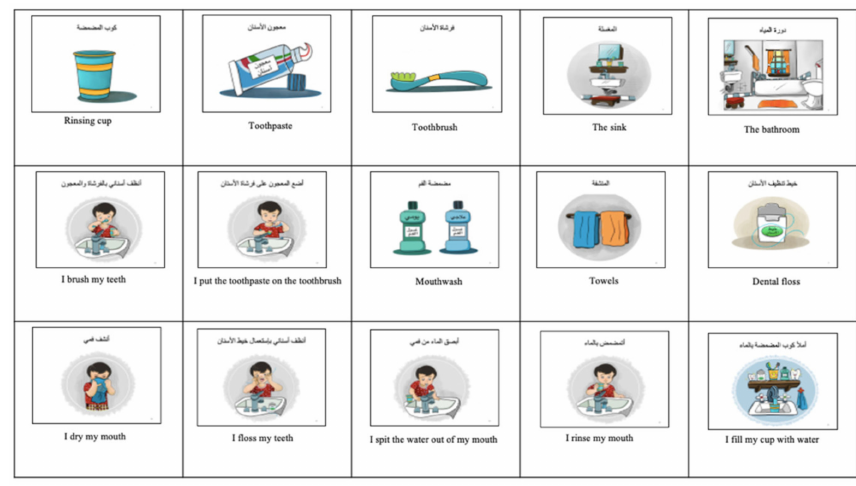
Figure 2. The culturally adapted dental visual aids: brushing teeth at home.